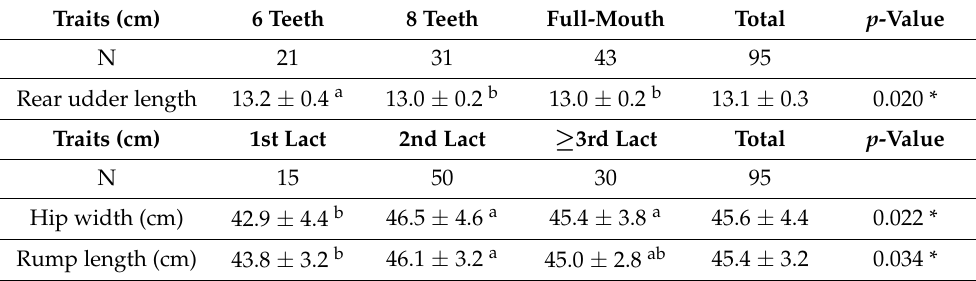
Table 8. Significant quantitative traits of Creole cows (N = 95) according to age and lactation 1 . Traits (cm) 6 Teeth 8 Teeth Full-Mouth Total p